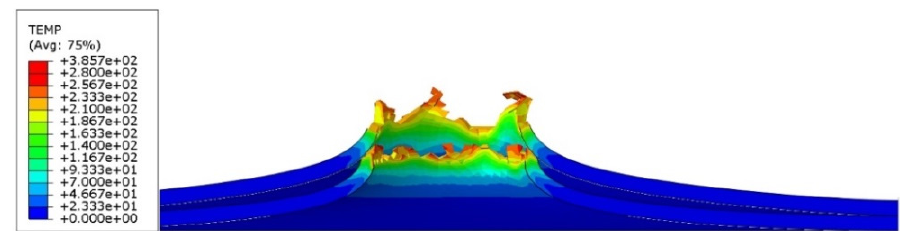
Figure 24. Temperature increment visualization due to the puncture of two layers of titanium alloy sheet by striker—section view.